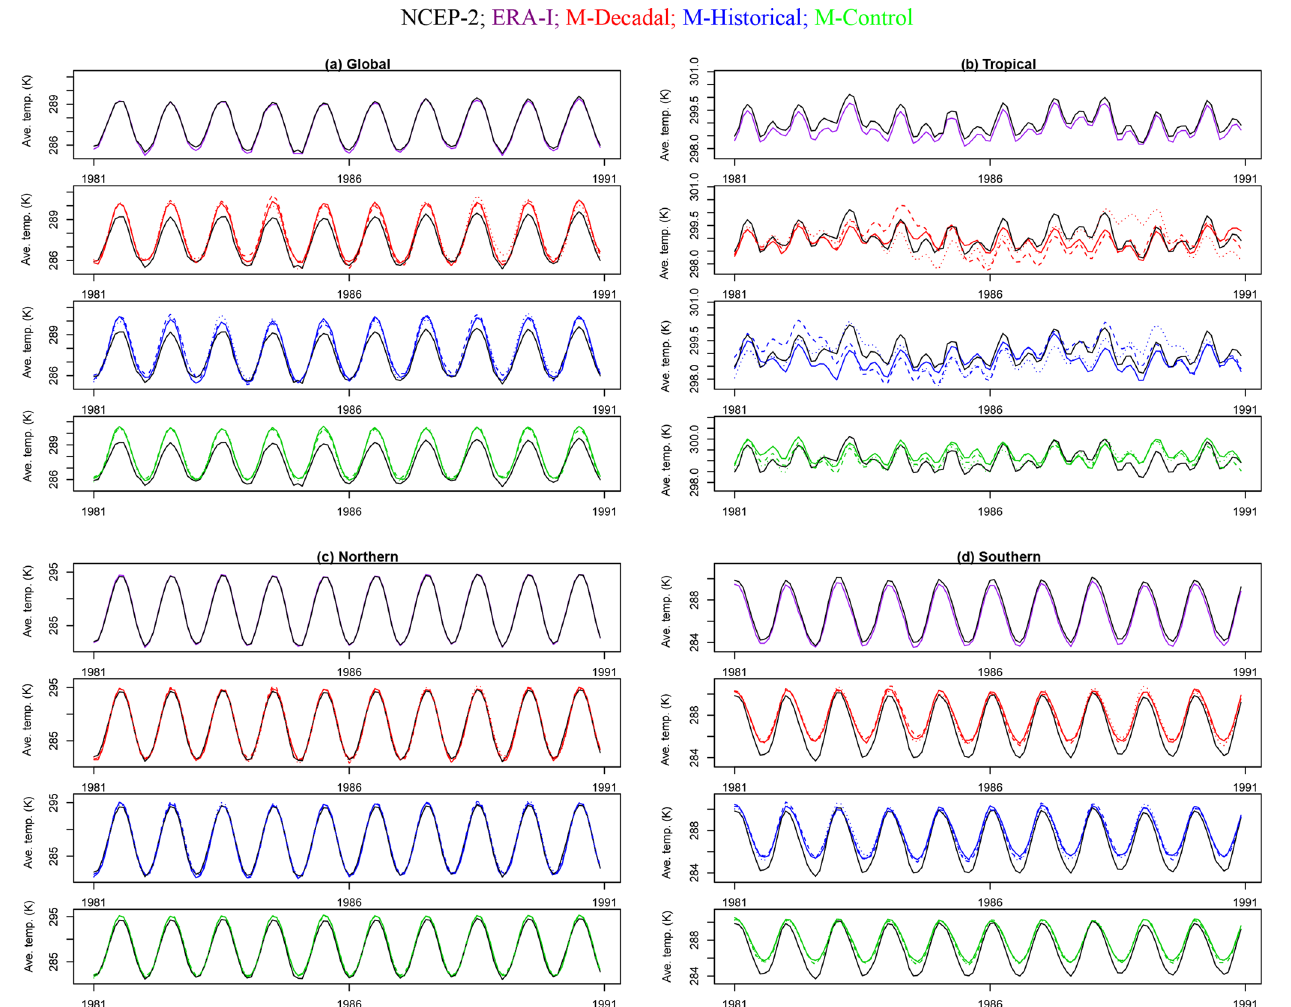
Figure 1. The 10-year series of monthly mean, spatially averaged 2m surface temperature from the MIROC5 model. The top plots in each panel correspond to NCEP-2 and ERA-Interim reanalyses. The three remaining plots in each panel correspond to the three different types of simulations, in vertical descending order, decadal, historical, and control (labeled “M-” for model in the header). Three realizations of each model simulation are indicated by different line types. The top panels represent global (a) and tropical (b) regions; the bottom panels represent the Northern Hemisphere (c) and Southern Hemisphere (d)